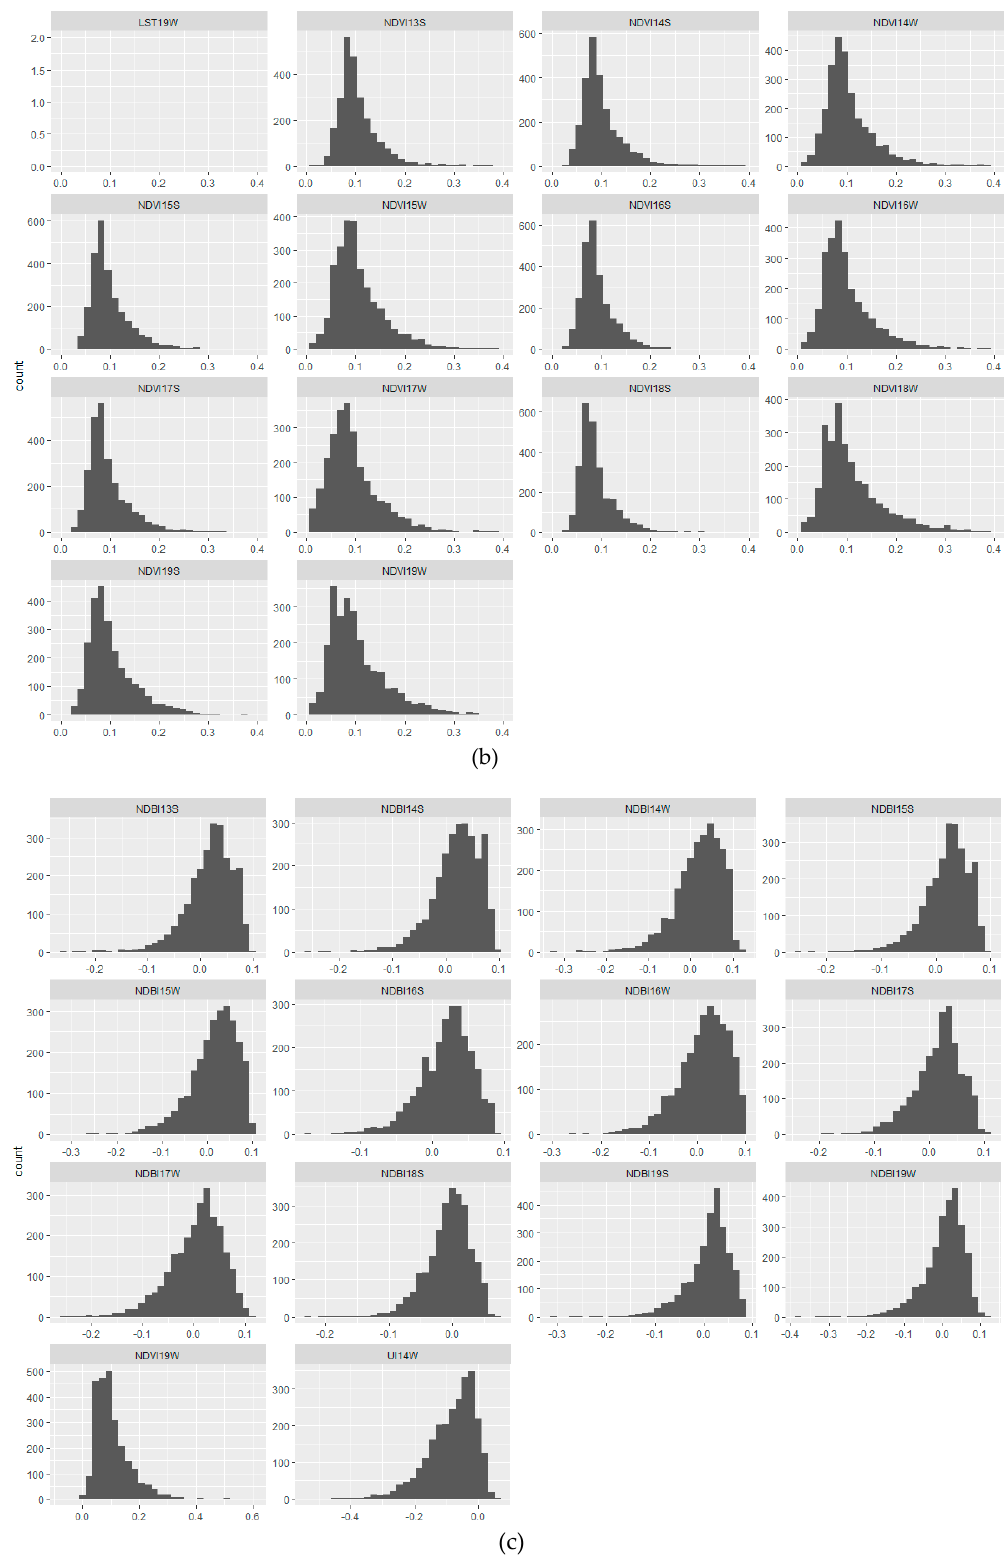
Figure A1. The distribution (histograms) of LST, NDVI and NDBI values over the hexagons. ( a ) Histogram of the LST distribution over the hexagons. (Units on the X-axis are in degrees Celsius (°C). ( b ) Histogram of the NDVI distribution over the hexagons. ( c ) Histogram of the NDBI distribution over the hexagons.